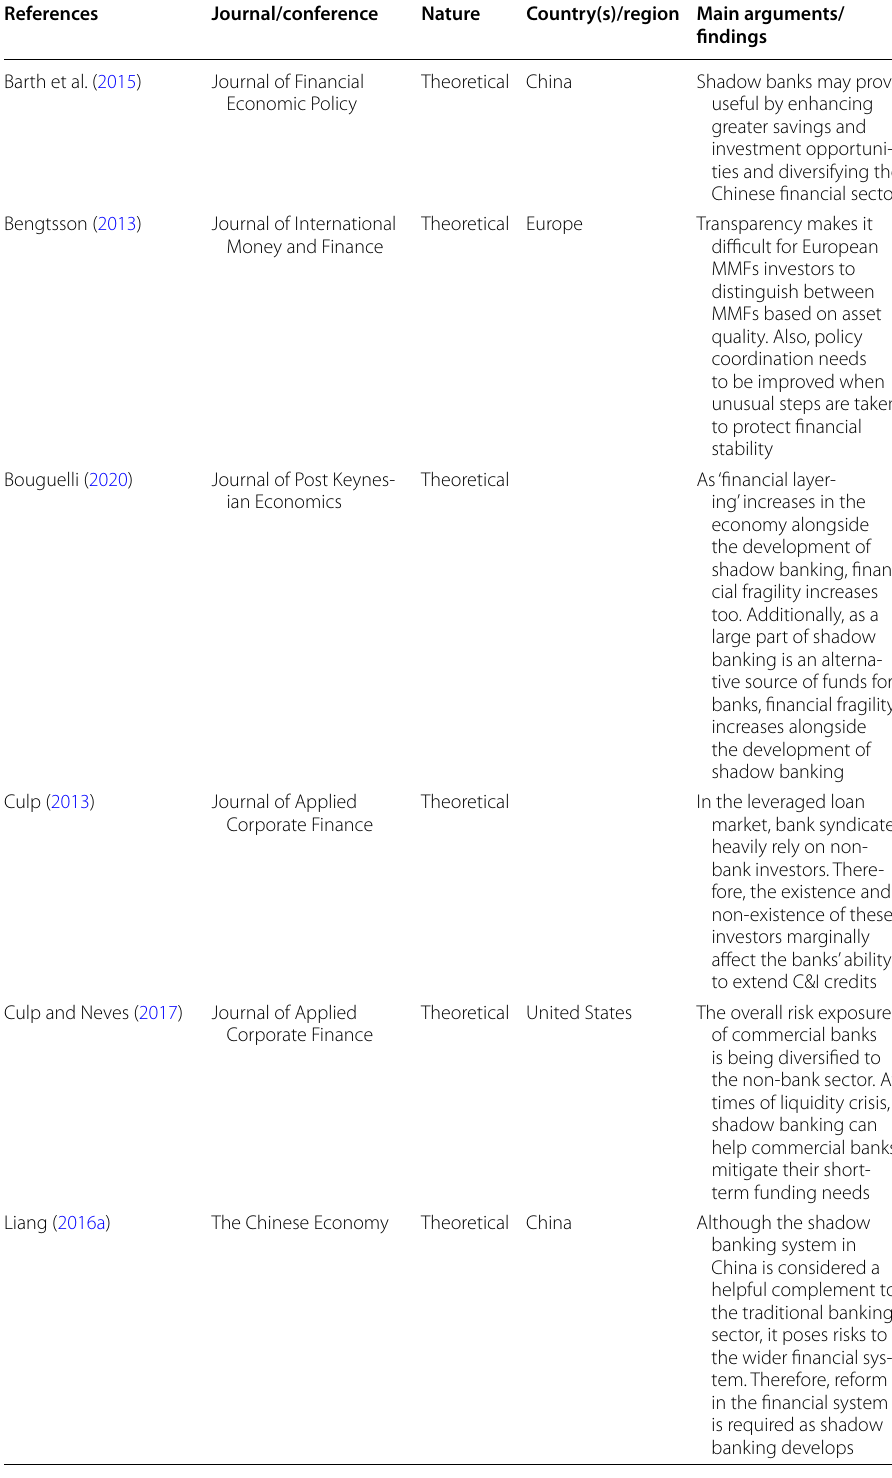
Table 7 Key literature on SB and financial